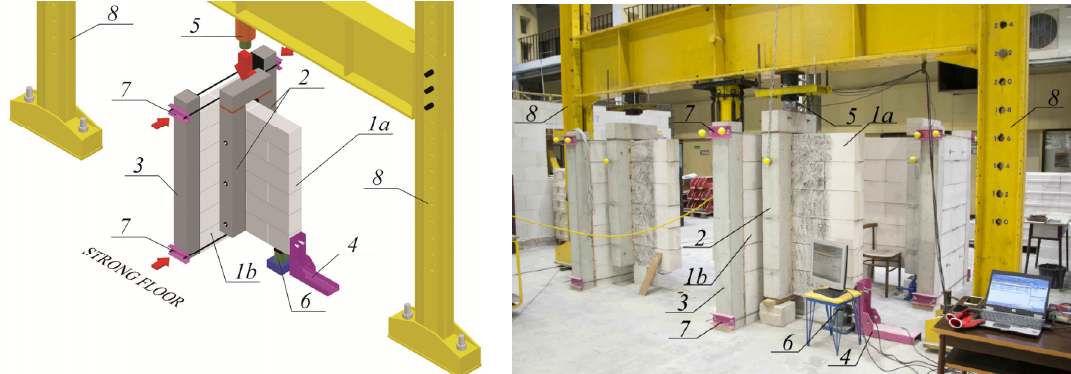
Figure 2. A scheme and photo of the test stand (longitudinal wall ( 1a ), transverse wall ( 1b ), reinforced